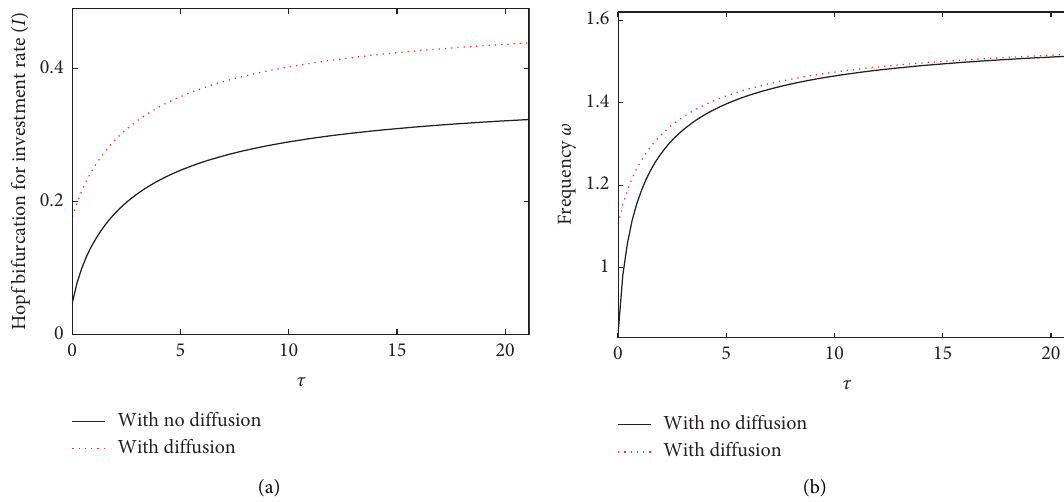
Figure 6: (a) The Hopf bifurcation maps in the τ − I plane and (b) the frequency of the periodic results for ω against τ . Here, we see results for two cases: d � 0 (no diffusion term) and d � 0 . 1 (diffusion term).